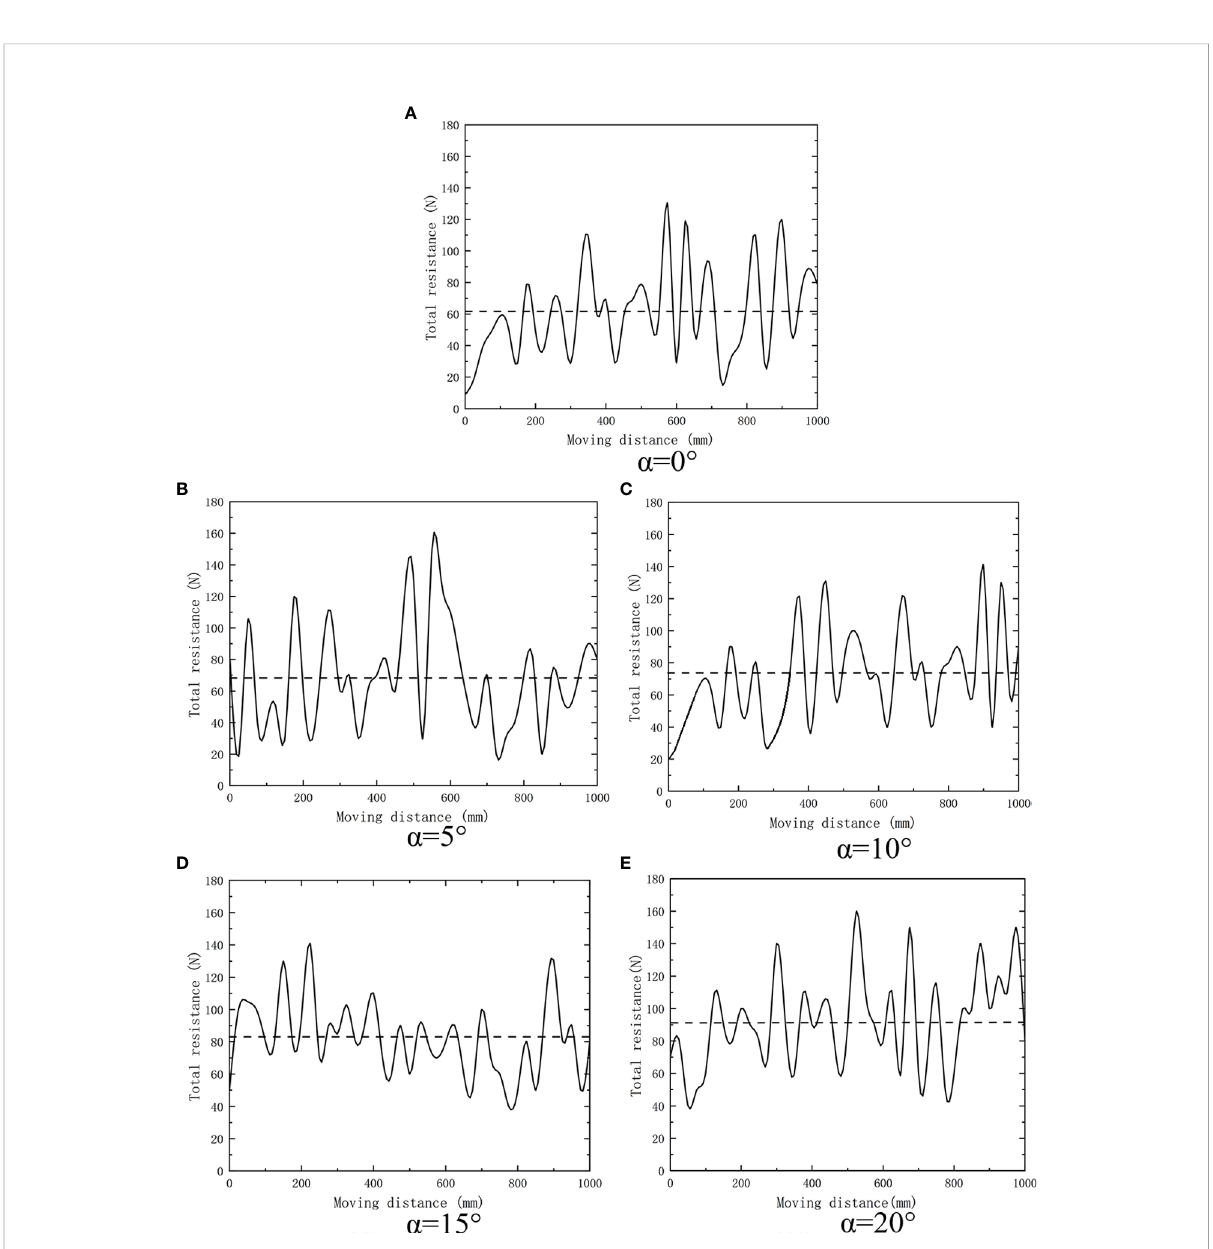
FIGURE 4 Comprehensive resistance diagram of weeding wheel at fi ve installation angles.